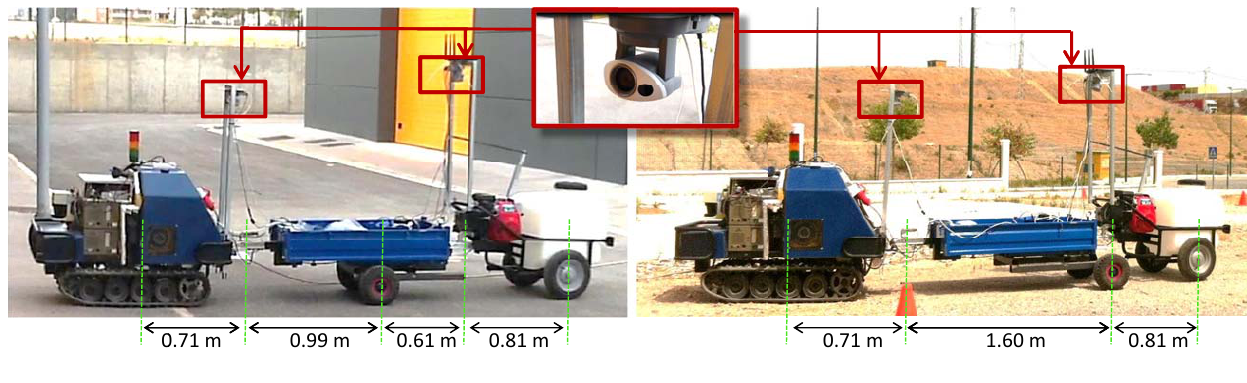
Figure 3. Auriga- α two-trailer vehicle with off/off-axle ( left ) and off/on-axle ( right ) setups with kinematic parameters and location of front and rear IP cameras. Inset: camera detail.